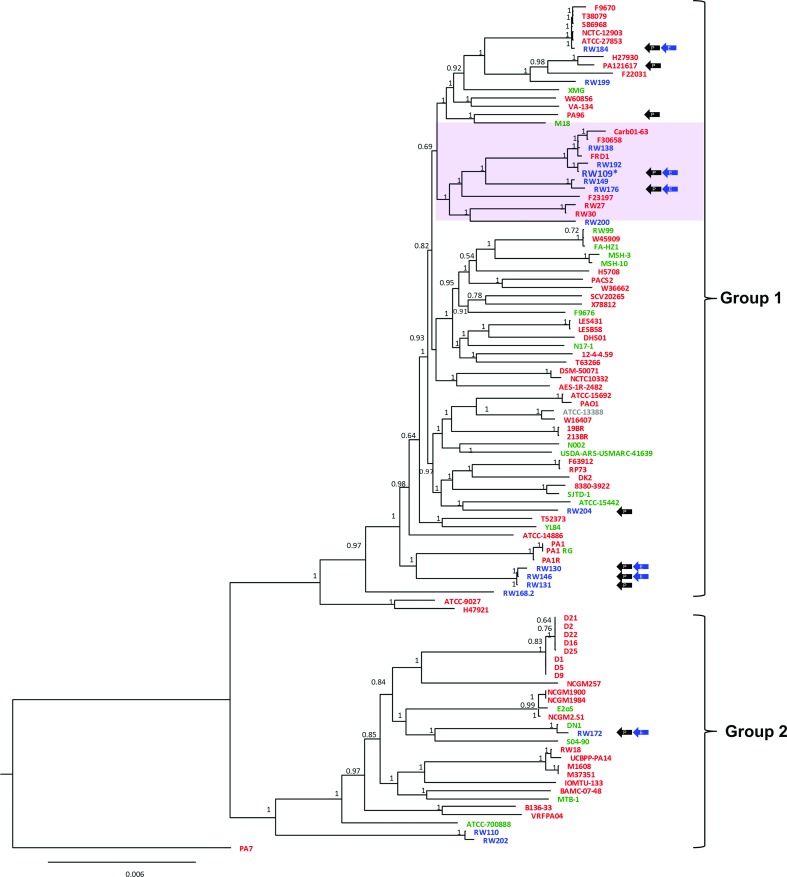
Widespread placement of industrial isolates within the core gene-based population structure of
P. aeruginosa
. A maximum-likelihood phylogenetic tree was generated based on the 4009 core genes identified within the 103
P. aeruginosa
 genomes. The strain names are colour coded to indicate their source: clinical (red, n=66), environmental (green, n=19) or industrial (blue, n=16); strain PA1RG is classified as both clinical and environmental and so is coloured red and green, and ATCC-13388 is coloured in grey as it was isolated from an unknown source. Bootstrap values (with 1 being 100 %) and genetic distance (the number of base substitutions per site) are indicated on the nodes and scale bar, respectively. The tree was rooted with the PA7 genome sequence as the most divergent
P. aeruginosa
 strain. The two major
P. aeruginosa
 groups are labelled (1 and 2), and the highlighted clade (purple square) containing the industrial strain, RW109, with a complete reference genome, is shown. Industrial strains uniquely encoding the BpeEF-OprC efflux pump (blue arrows; E) and the megaplasmid parB gene (black arrows; P) are indicated.